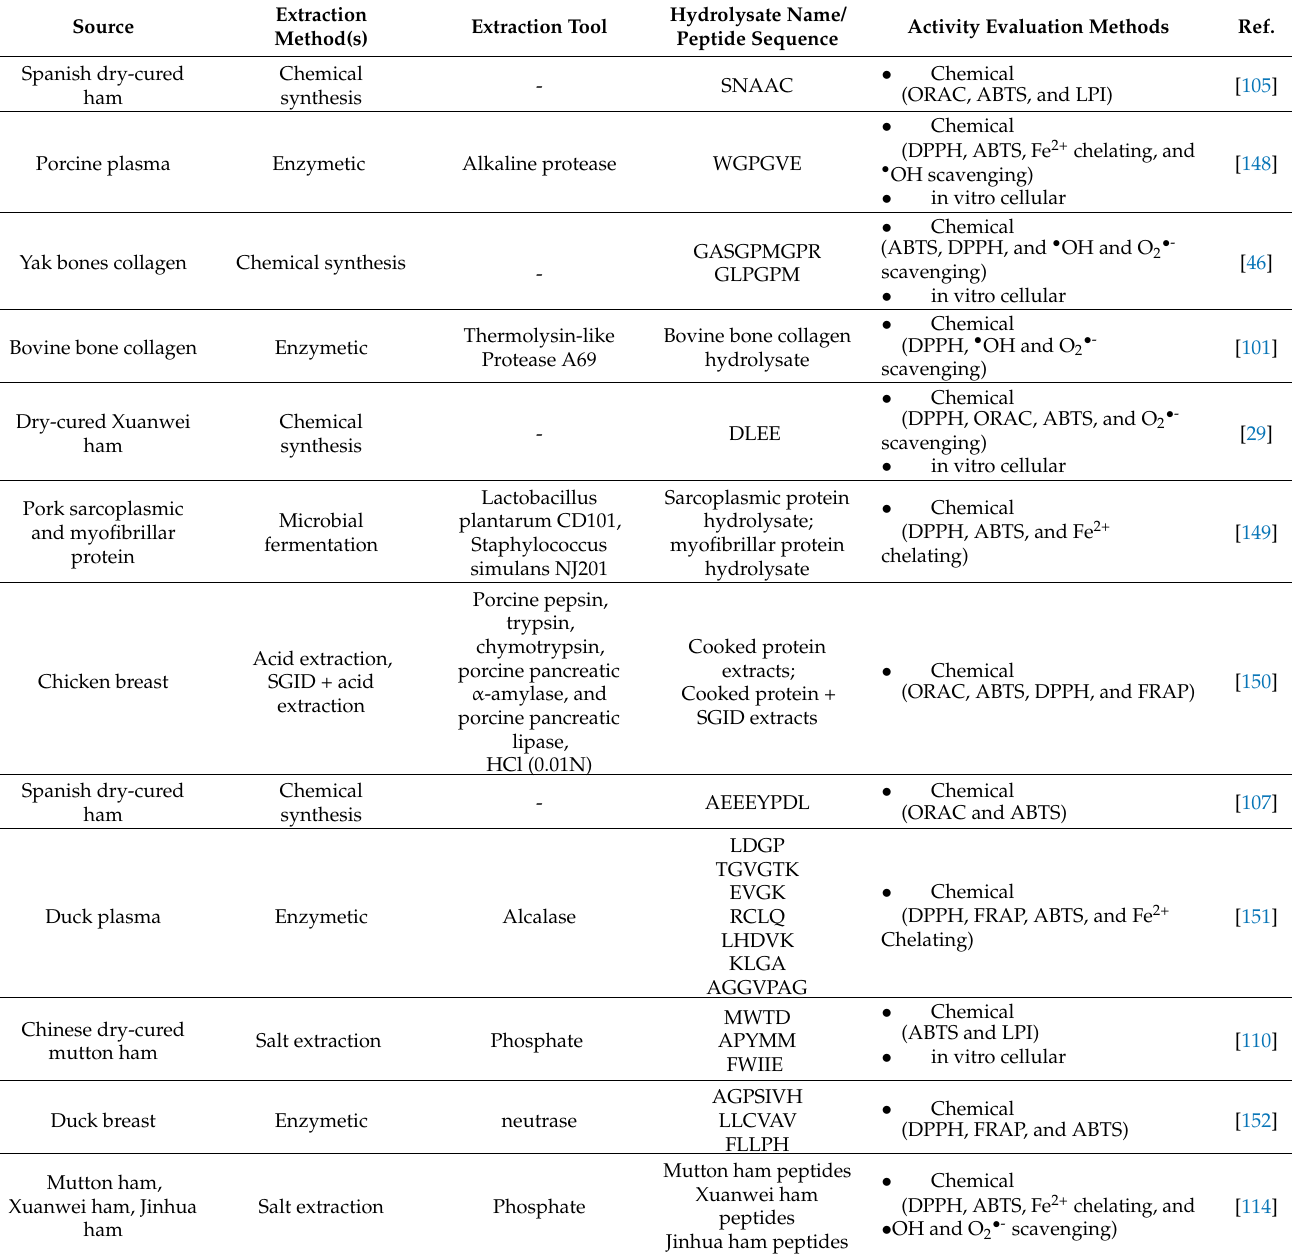
Table 2. Animal sources of antioxidative hydrolysates and